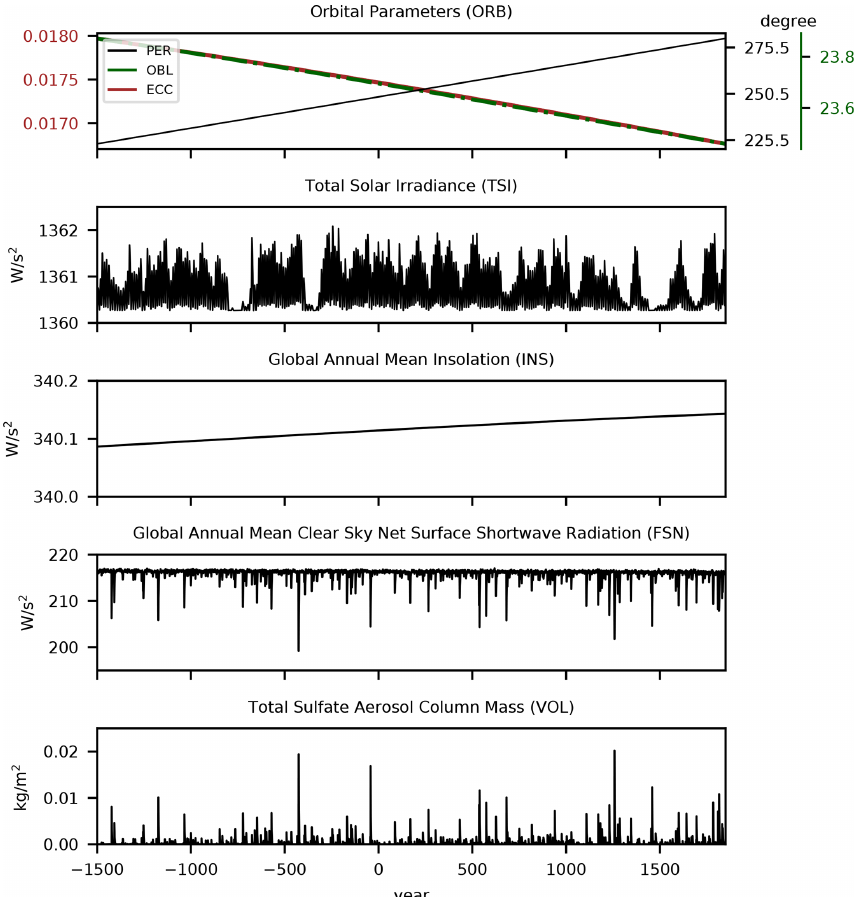
Figure 3. Time series of externally forced variability included as covariates in the non-stationary GPD models for the orbital-only and full-forcing simulations. Note that the VOL-covariate GPD model is only generated for the full-forcing simulation.